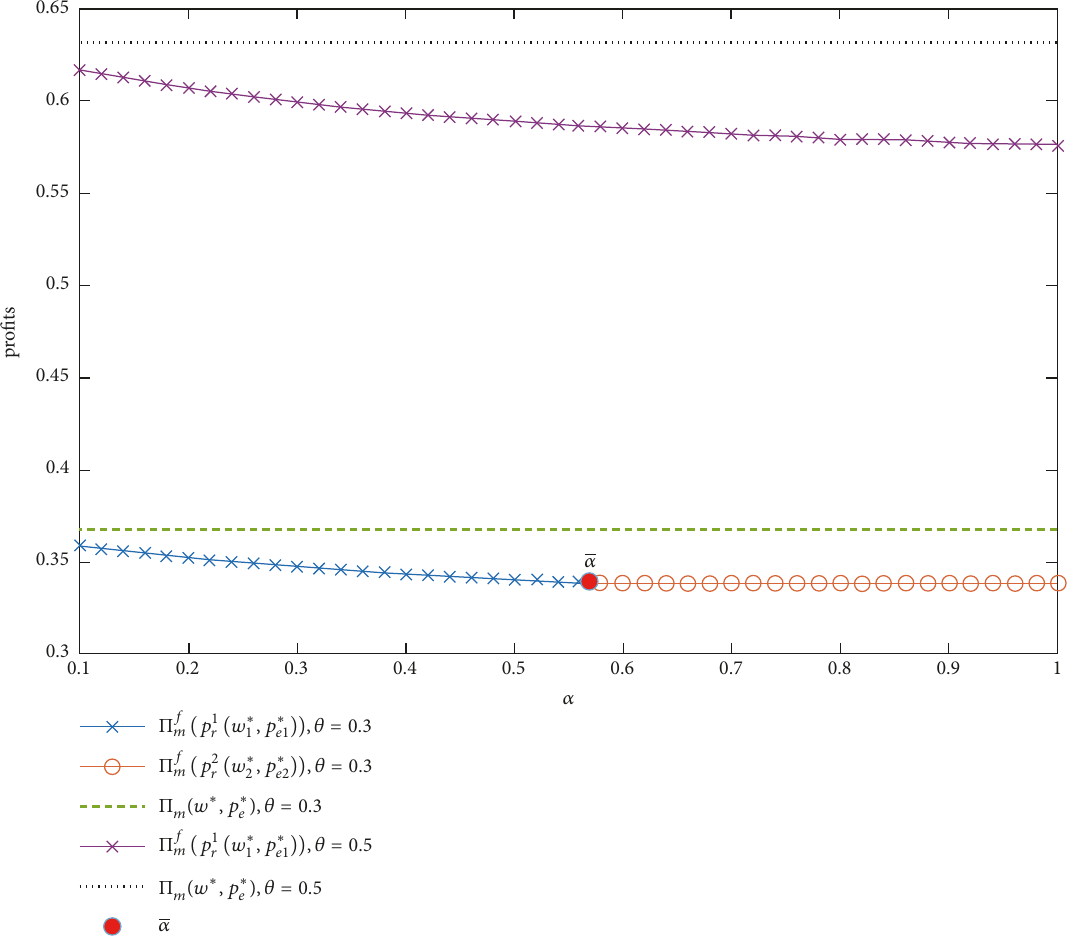
Figure 5: Impact of 𝜃 and 𝛼 on 𝜋 𝑓 𝑚 for the two